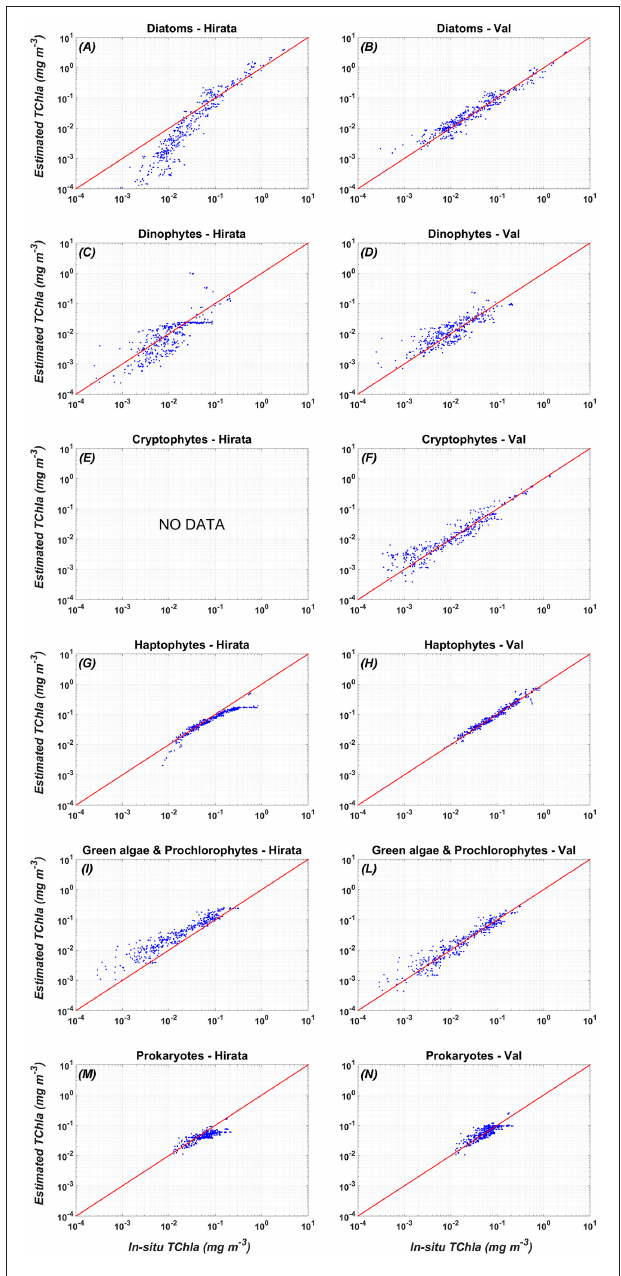
FIGURE 4 | Comparison between the validation of the new PFT regional algorithms (Val, right panel: B,D,F,H,L,N) vs. the global PFT model of Hirata et al. (2011) (Hirata, left panel: A,C,E,G,I,M) : in-situ (x axis) vs. estimated (y-axis) PFT TChla concentrations. (A) Diatoms-Hirata, (B) Diatoms-Val, (C) Dinophytes-Hirata, (D) Dinophytes-Val, (E) Cryptophytes-Hirata, (F) Cryptophytes-Val, (G) Haptophytes-Hirata, (H) Haptophytes-Val, (I) Green algae & Prochlorophytes-Hirata, (L) Green algae & Prochlorophytes - Val, (M) Prokaryotes - Hirata, (N) Prokaryotes - Val. For the statistics, see Table 7 .